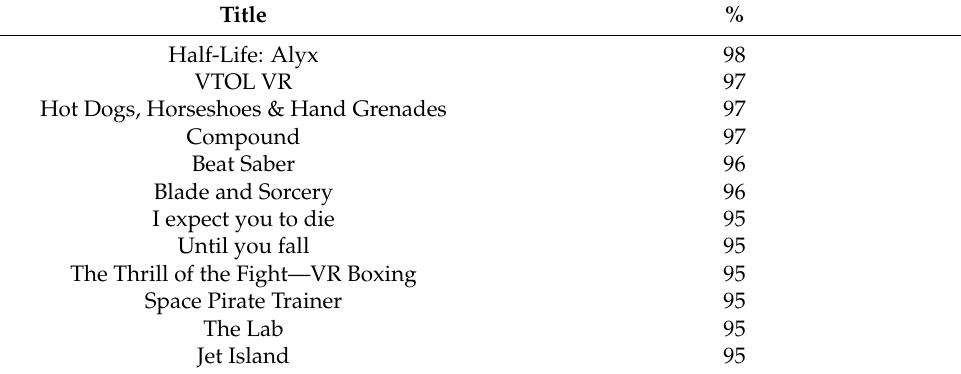
Table 6. VR applications with “overwhelmingly positive” reviews in the category of action VR apps [state on 6 July